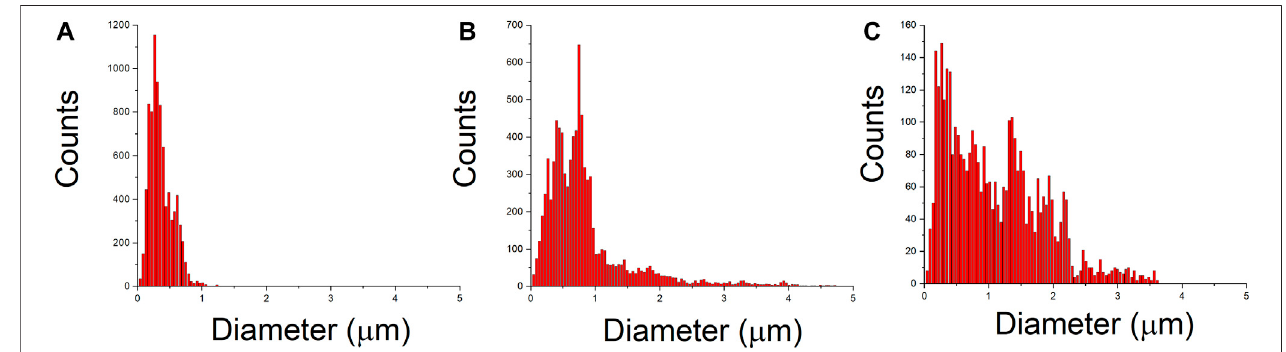
TABLE 2 | Sheet resistances of the electrospun randomly oriented fi bers non-woven for three different electrospinning times. Electrospinning time (sec)